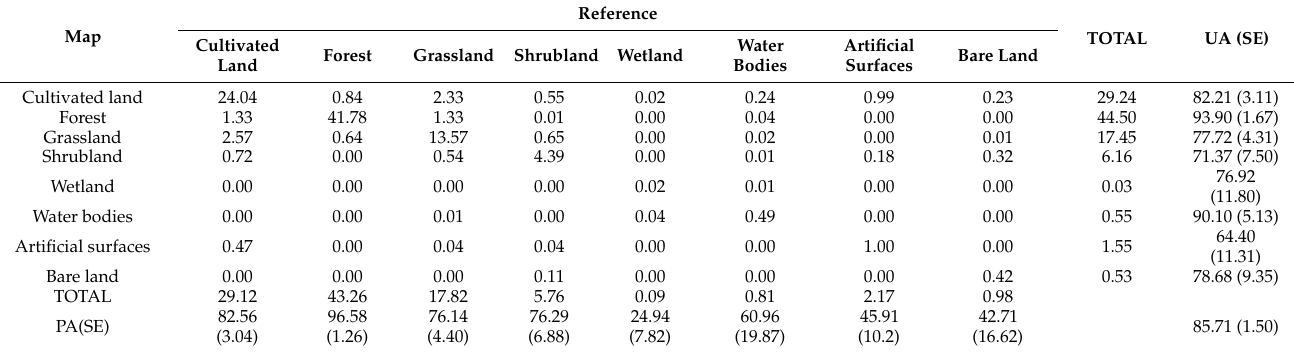
Table A10. Error matrix of fused product 2010 using modified